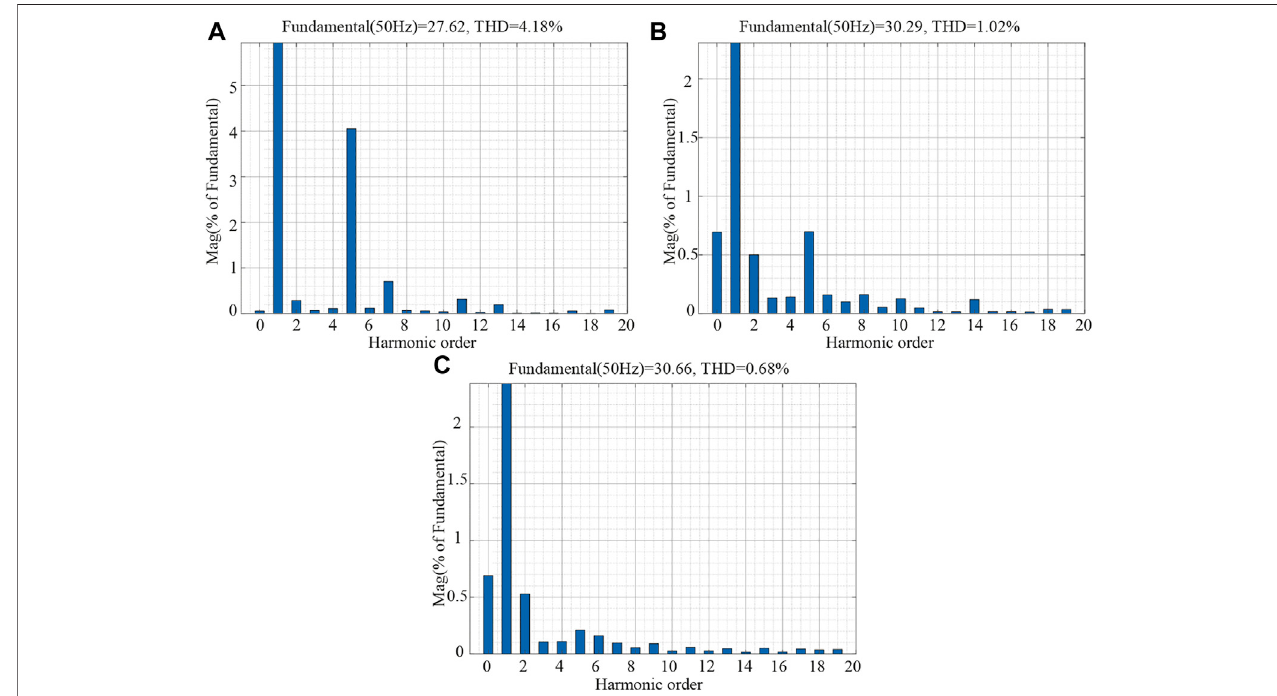
FIGURE 22 | Grid-connected current THD; (A) traditional control without compensation; (B) with DVC compensation; (C) with PLL compensation.